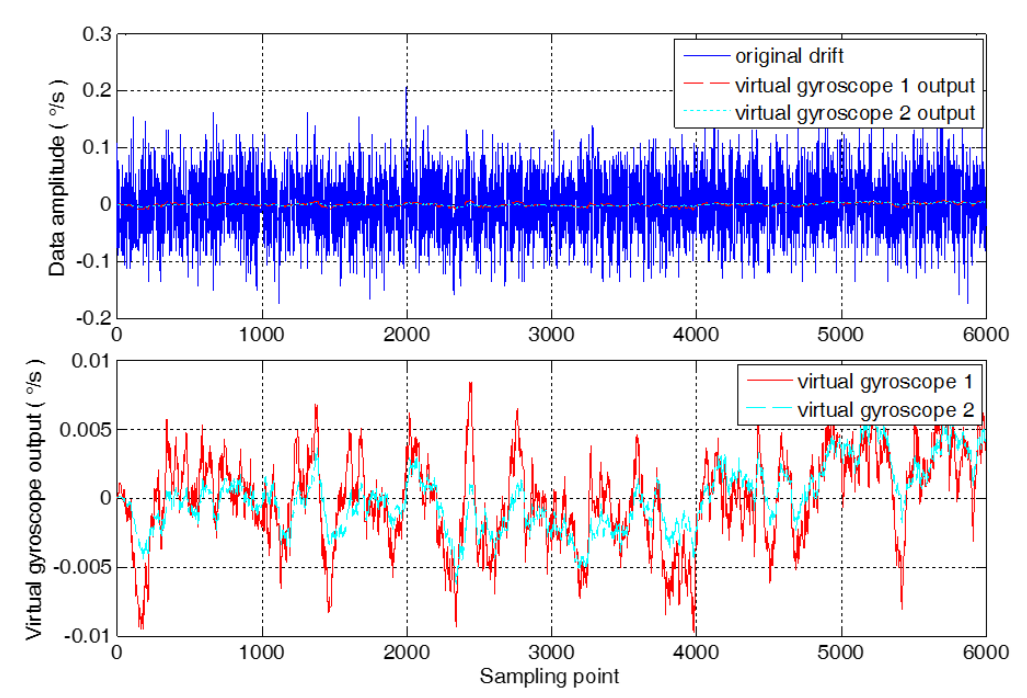
Figure 7. The comparison of the output of the virtual